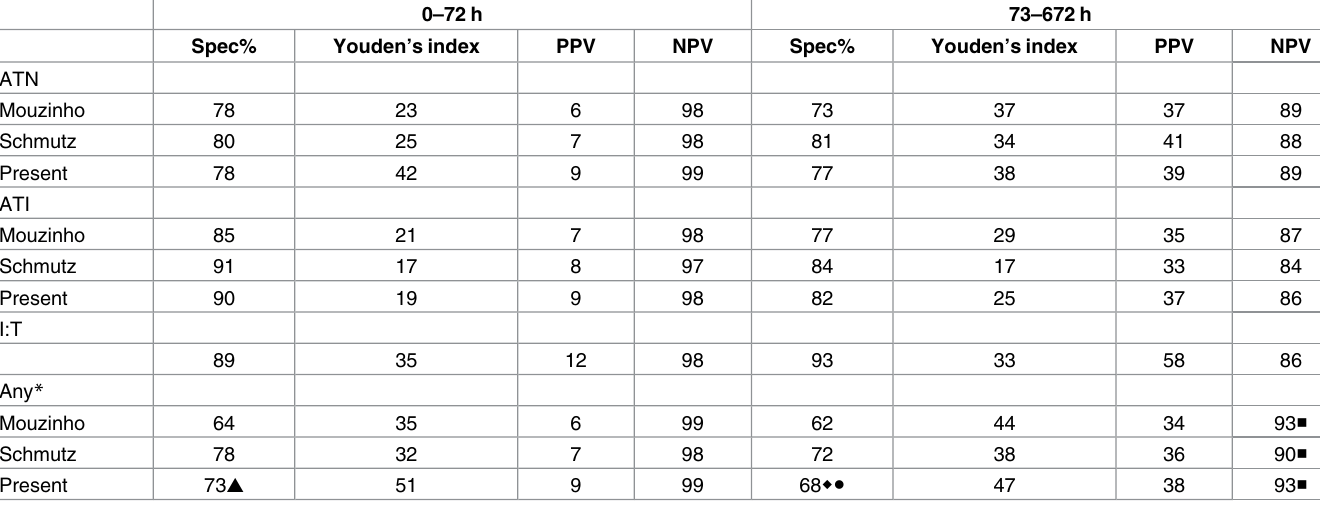
Table 3. Comparison of specificity and predictive values of the revised RRs and those of Mouzinho’s RRs and Schmutz’s RRs for neutrophil parameter values by comparing uninfected with proven sepsis in VLBW